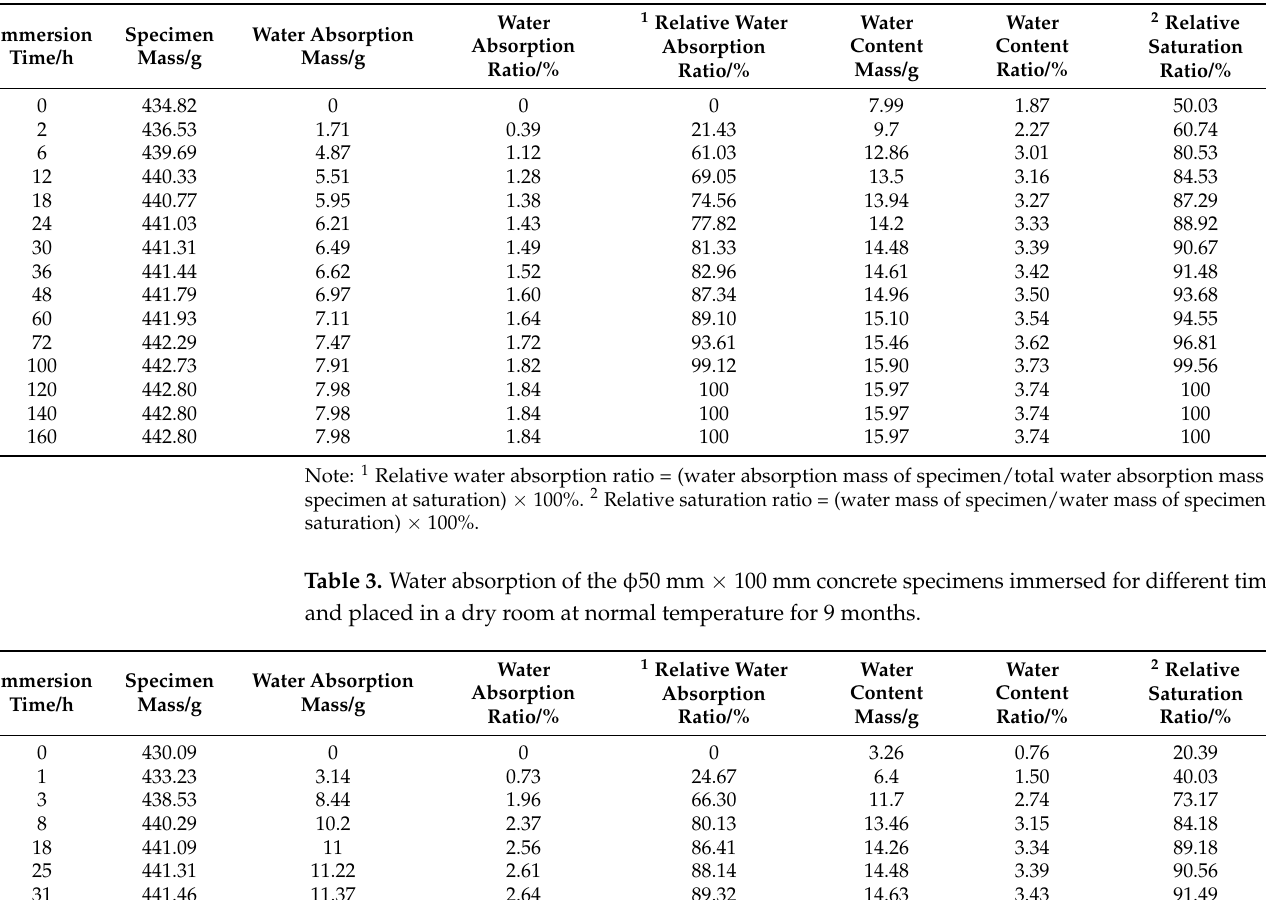
Table 2. Water absorption of the φ 50 mm × 100 mm concrete specimens immersed for different times and placed in a dry room at normal temperature for 3 months.